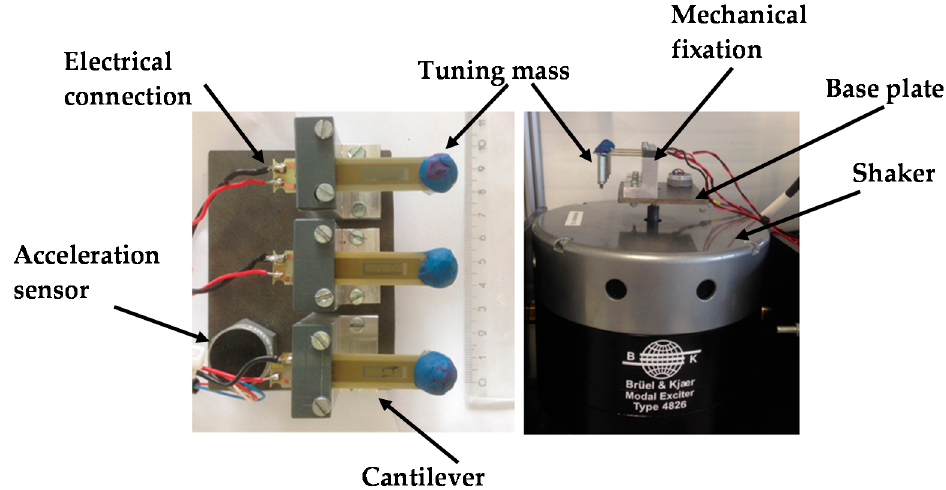
Figure 3. Mechanical set up with a PEC array.